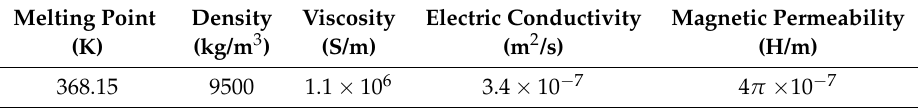
Table 1. The material properties of low melting point Pb-16wt%Sn-52wt%Bi alloy.